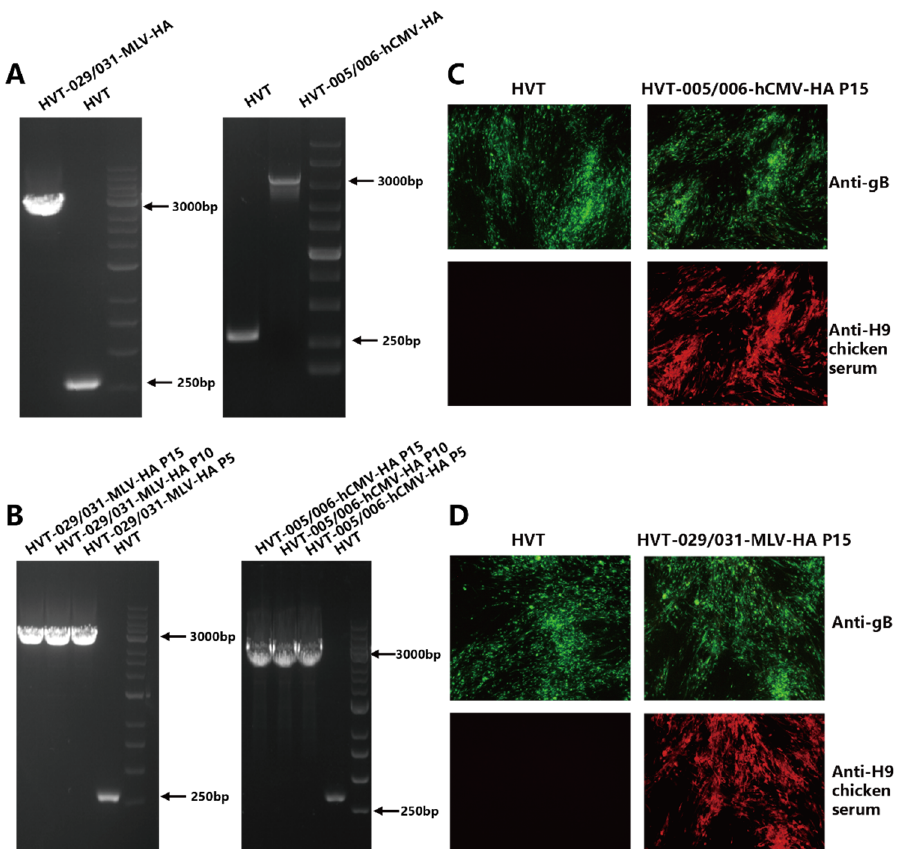
Figure 1. Characterization of the recombinant HVT-029/031-MLV-HA and HVT-005/006-hCMV- HA. ( A ) PCR analysis of the inserted HA gene cassette in the HVT005/006 or HVT029/031 site. ( B ) PCR analysis to confirm the presence of HA expression cassette from HVT-029/031-MLV-HA and HVT-005/006-hCMV-HA at passage 5, 10, and 15 in CEFs using primer pairs outside of the insertion site. ( C ) Detection of HA expression from HVT-005/006-hCMV-HA at passage 15 in CEFs by IFA using anti-H9 chicken serum. HVT infection was confirmed by IFA with anti-gB monoclonal antibody BD8. ( D ) Detection of HA expression from HVT-029/031-MLV-HA at passage 15 in CEFs by IFA using anti-H9 chicken serum. HVT infection was confirmed by IFA with anti-gB